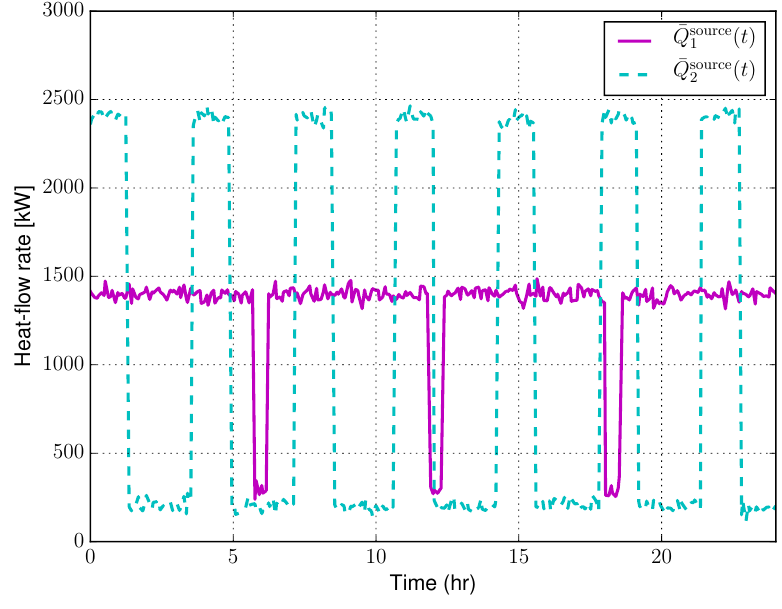
Figure 4. Heat-flow rates from source plants.